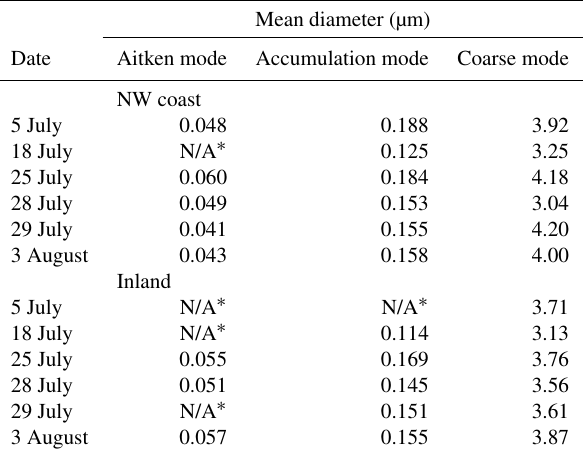
Table 2. Mean diameter of distinct aerosol modes measured over the NW coast and inland on the different case study